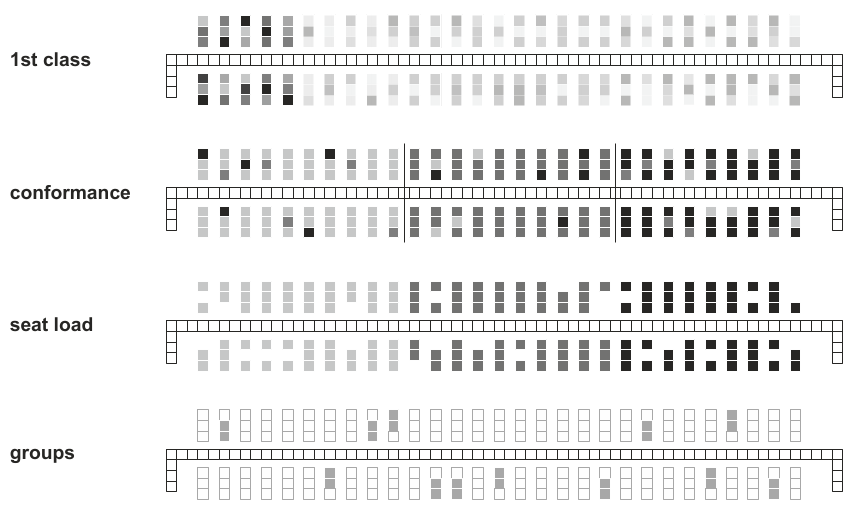
Figure 5. Consideration of operational constraints in the stochastic boarding model.